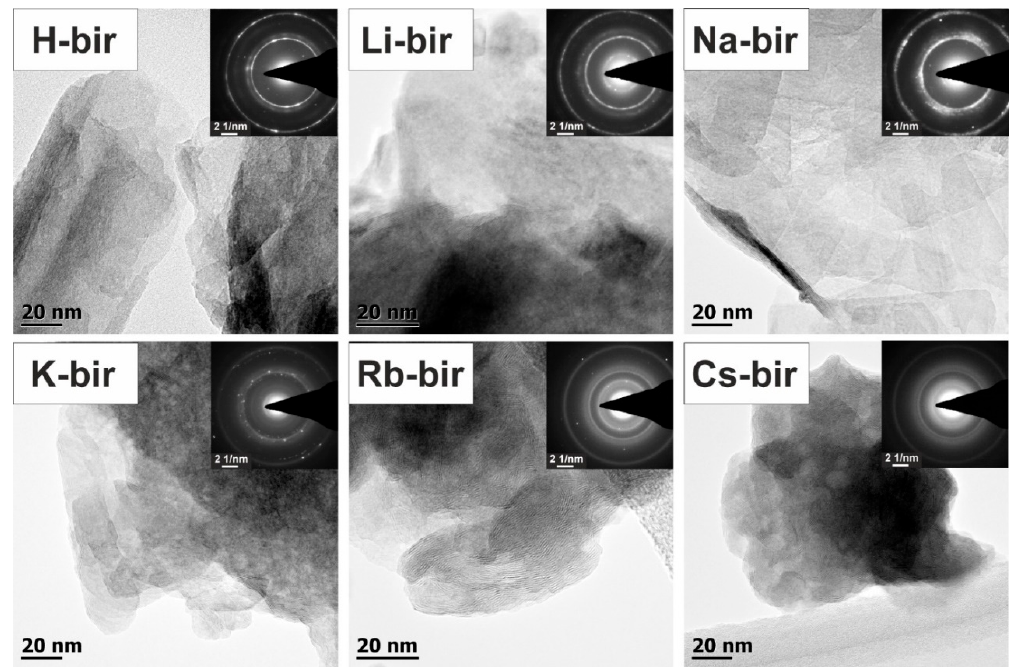
Figure 5. TEM detail aspect images of the bulk alkali-promoted birnessite catalysts along with the corresponding selected area electron di ff raction patterns shown in the insets. Depending on the cation presence, a di ff erent birnessite morphology can be observed, varying from the 2D folded birnessite sheets for H-bir and Li-bir, with pronounced elongated and fragmented nanograins for Na-bir and K-bir, following the 3D compacted denser structures for Rb-bir and Cs-bir comprised of birnessite nanograins.